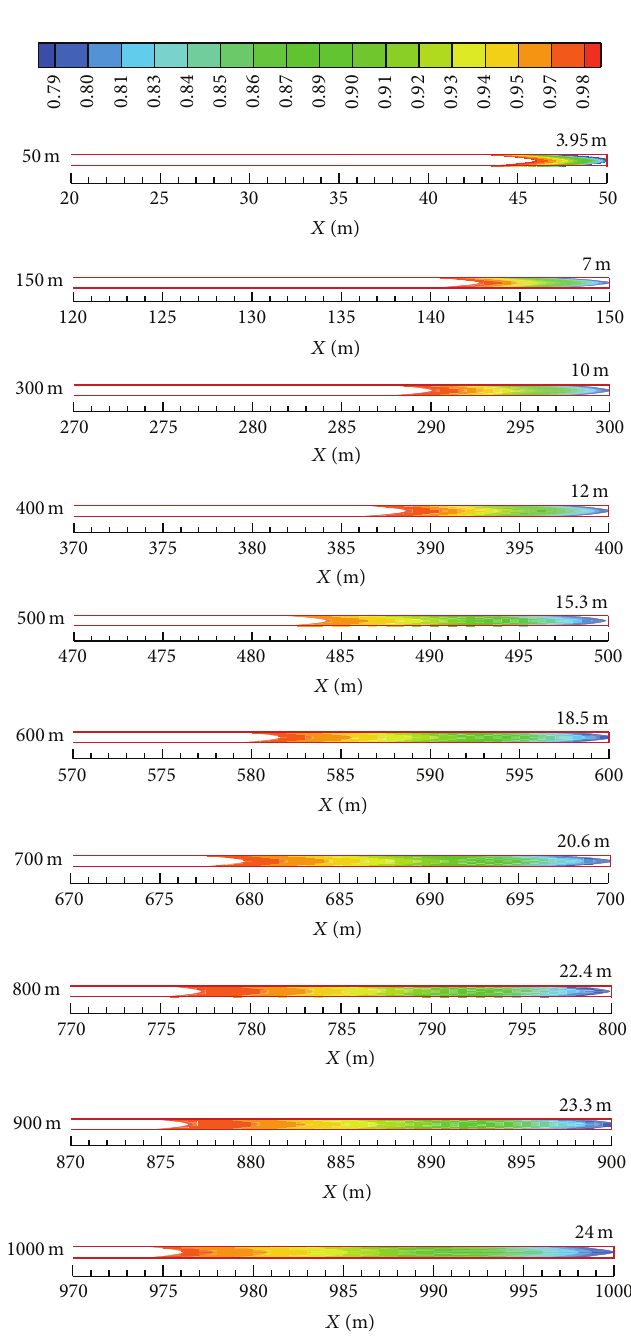
Figure 4: The maximum gas mixture length for different pipe